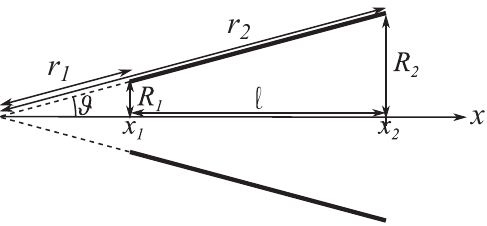
Figure 1. Sketch of a conical tube. L ¼ r 2 (cid:1) r 1 ¼ ‘= cos